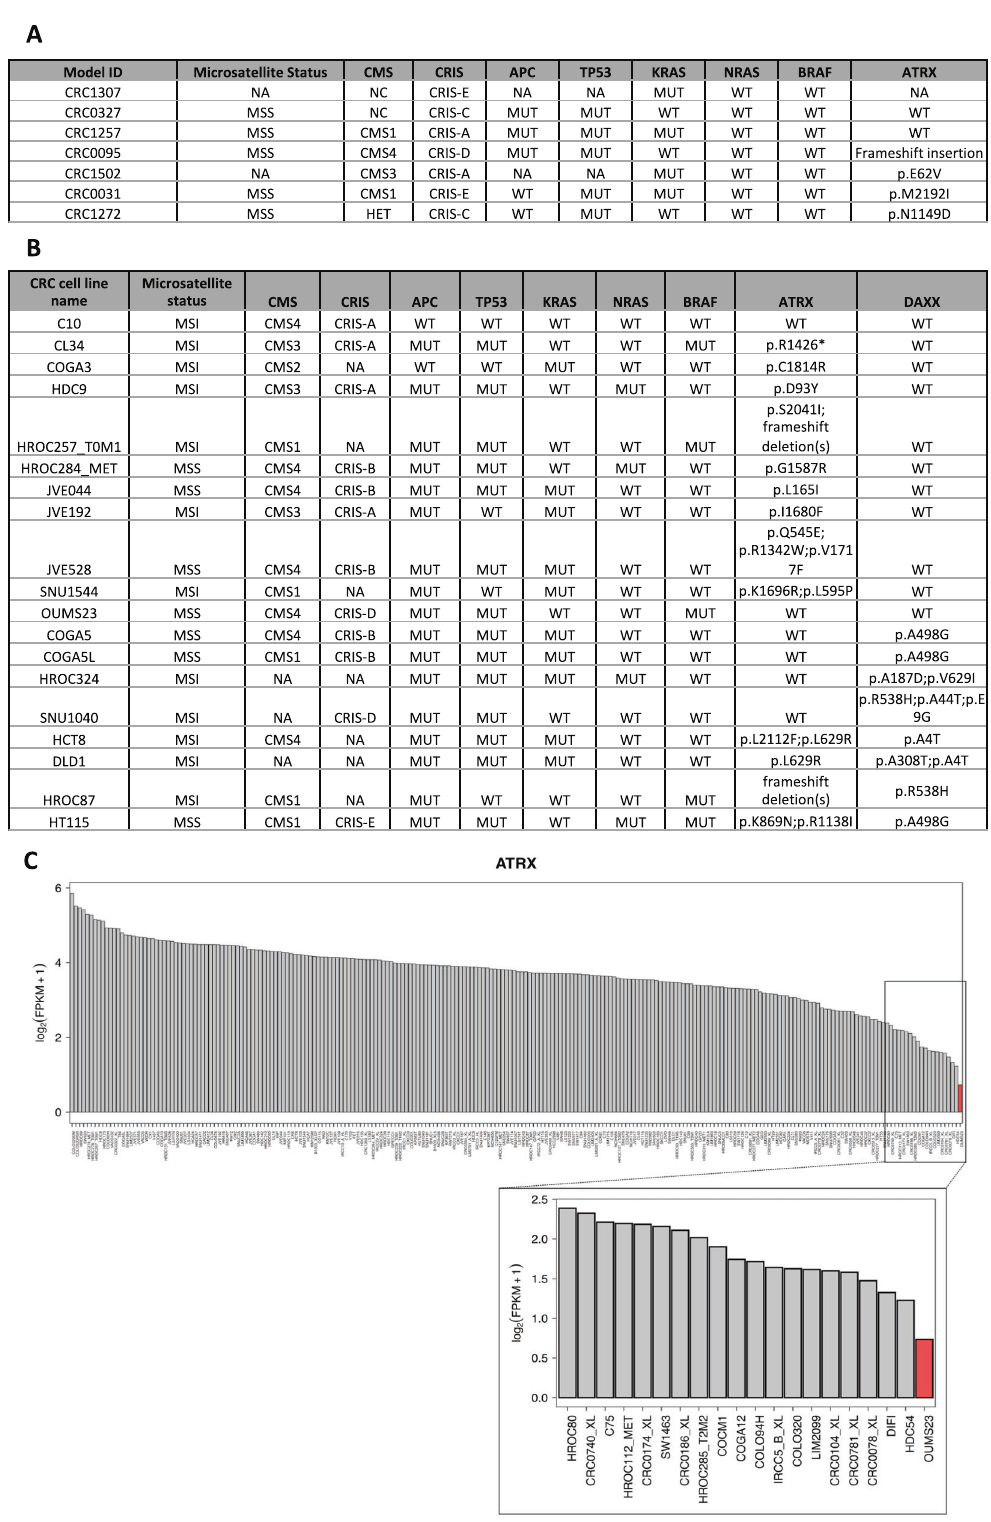
Fig. 3 List of PDOs and cell lines selected for a further assessment of ALT markers. A The table lists the 7 PDOs studied for ALT markers, indicating microsatellite status, consensus molecular subtype (CMS), CRIS type together with mutational status in key oncogenes, tumor suppressors and the ALT-associated gene ATRX . B The table shows the 19 CRC cell lines characterized, indicating microsatellite status, consensus molecular subtype (CMS), CRIS type together with mutational status in key oncogenes, tumor suppressors and ATRX and DAXX alterations. C ATRX mRNA expression levels in CRC cell lines. OUMS23 cell line showed the lowest level of ATRX expression and was included in our screens.